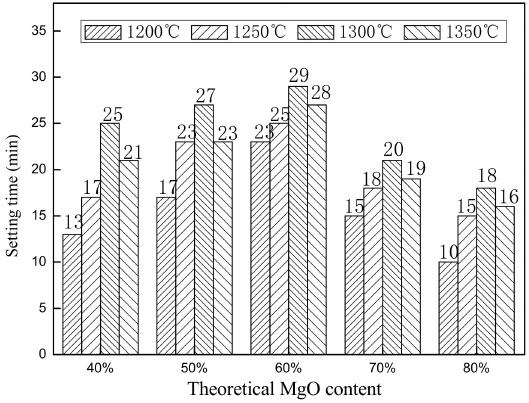
Figure 11. SAC-MKPC sample setting time.